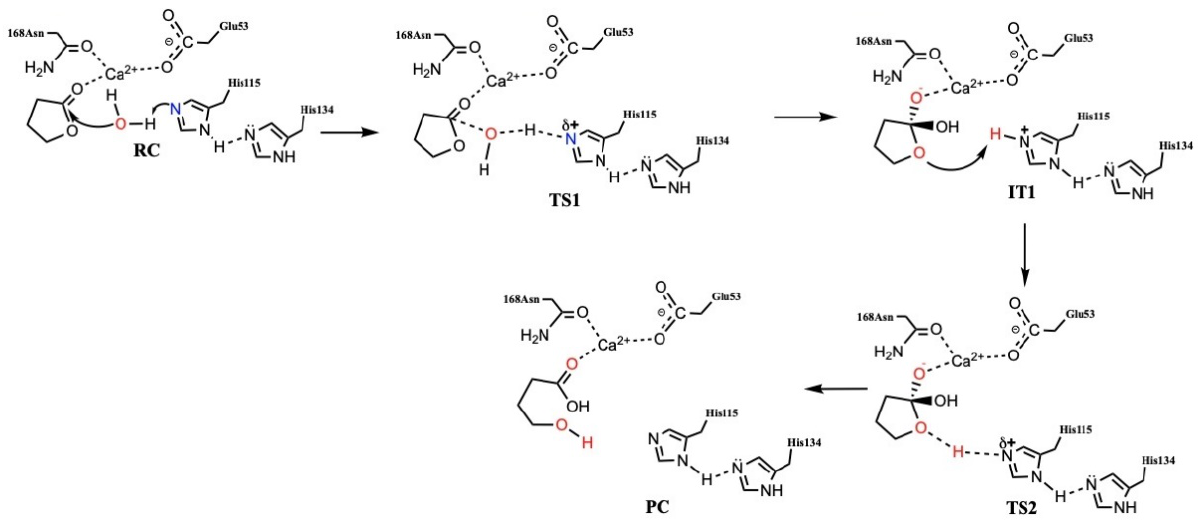
Figure 1. One of the proposed [18,19] catalytic mechanisms of PON1 (RC = Reactant complex; TS = Transition State; IT = Intermediate; and PC = Product Complex).